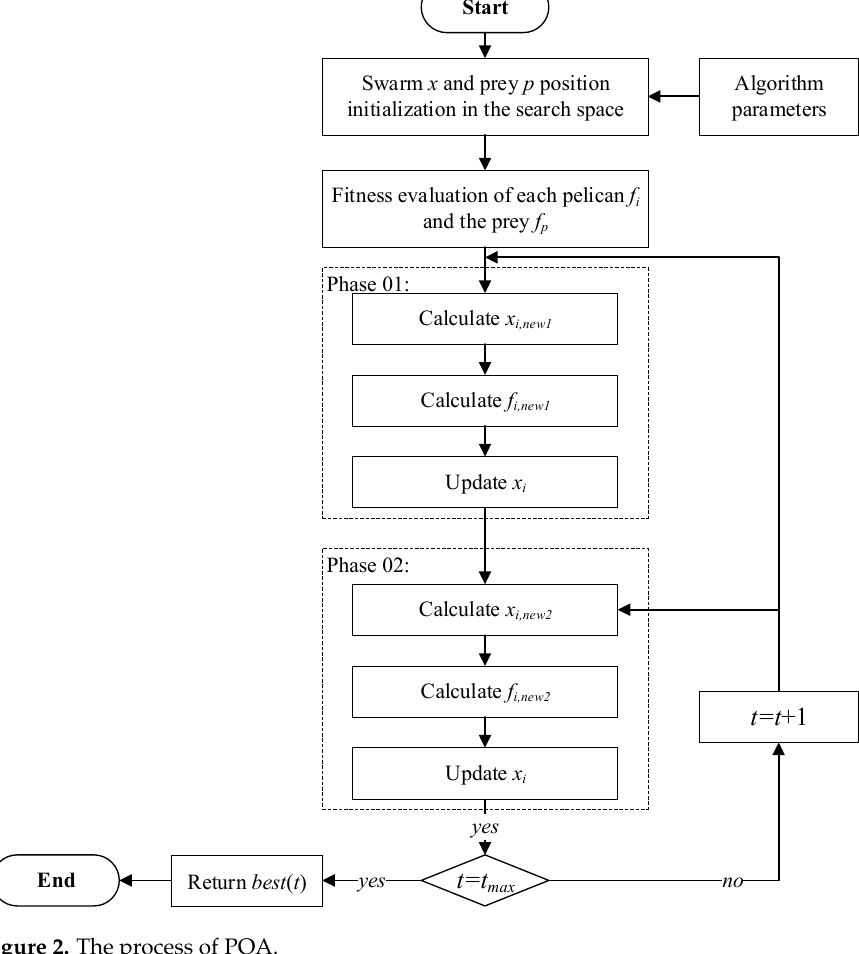
Figure 2. The process of